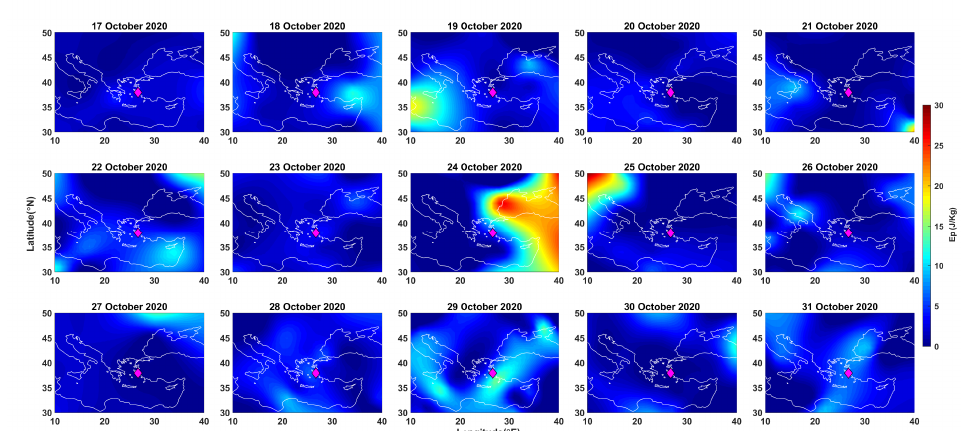
Figure 6. Spatial variation of potential energy at an altitude of 47 km from 17–31 October 2020. Along the x -axis and y -axis, we present the longitude and latitude, respectively. The magenta diamond represents the epicenter of the EQ, and the white lines indicate the country border.